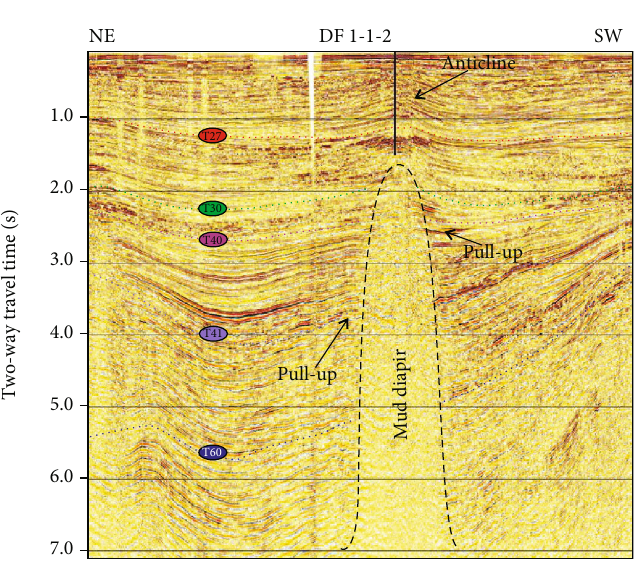
Figure 3: Seismic pro fi le over the Yinggehai Basin. There are blank and cluttered anomalous seismic emission characteristics that are signi fi cantly di ff erent from the surrounding rocks. The mud diapir is developed in the Miocene stratum, piercing the T30 interface in a vertical column and reaching the upper stratigraphic layer of the Yinggehai Formation stratum. Above the top of the diapir, there is a phenomenon of upward arching of the stratum. Uplift of the mud diapirs caused the “ pull up ” of the surrounding rock on both